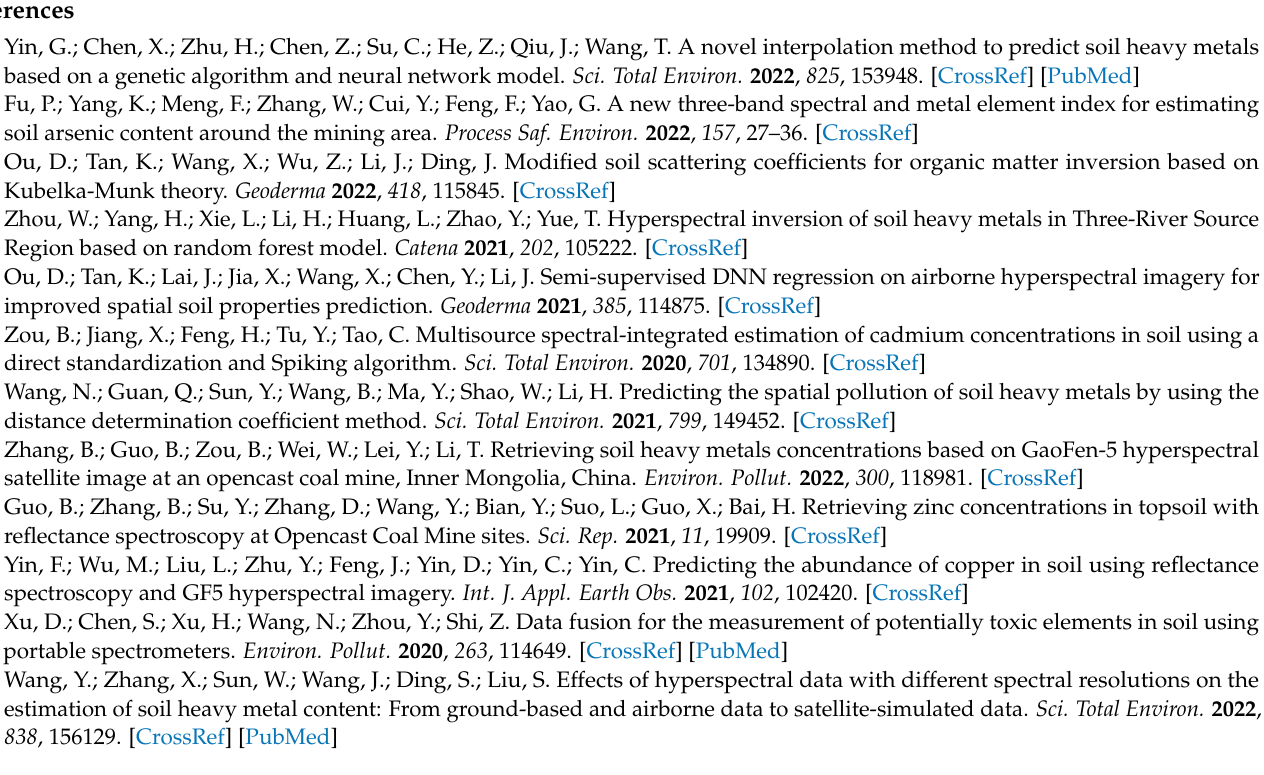
Table S1: Accuracy evaluation of different spectra pretreatment